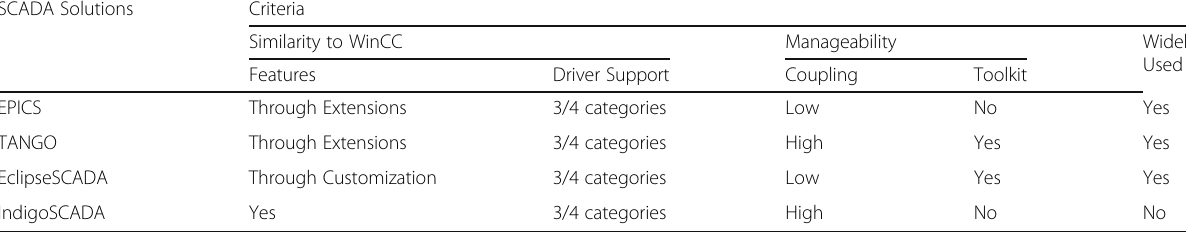
Table 3 Examination of open-source SCADA solutions SCADA